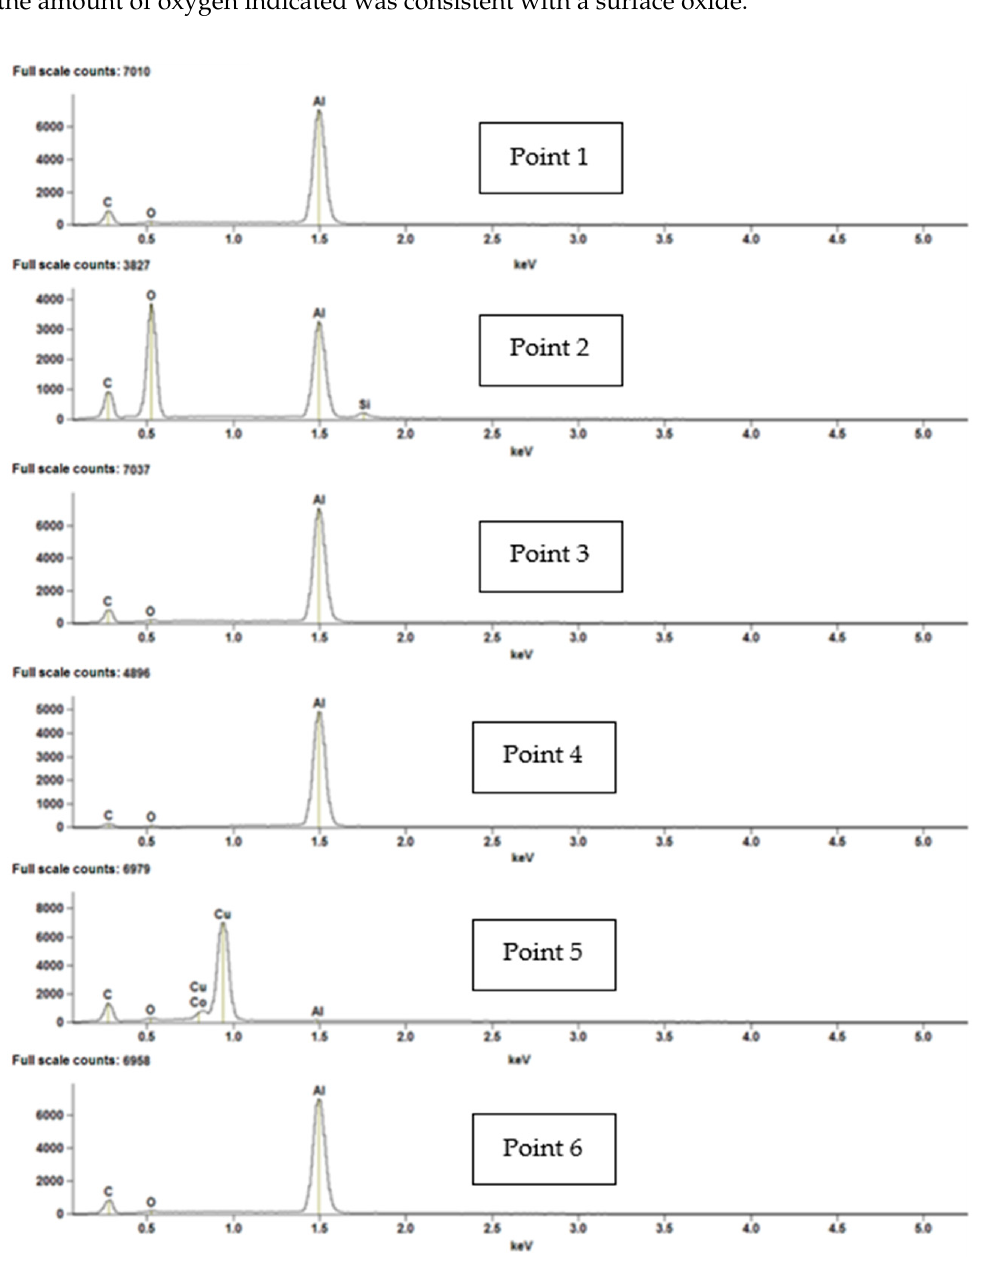
Figure 14. EDS of an aluminum particle with agglomerate.